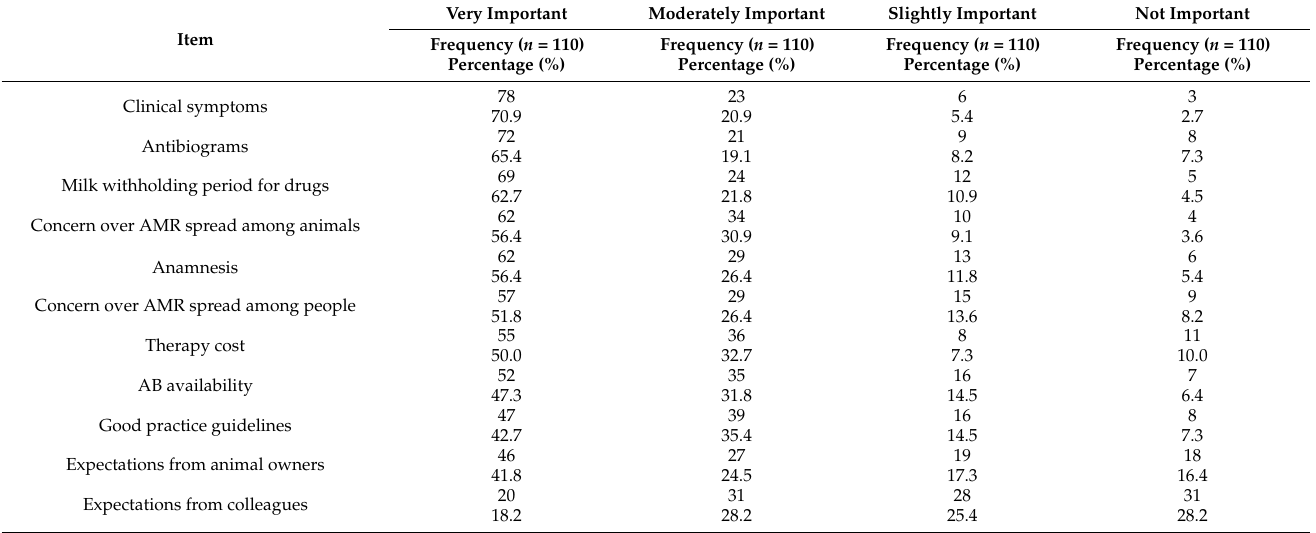
Table 9. Factors that influence AB prescription.